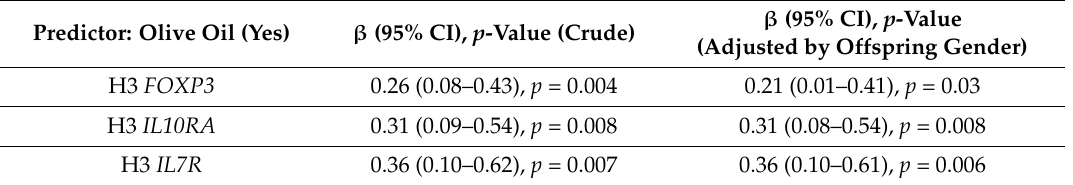
Table 2. Association between olive oil consumption and H3 acetylation levels in placenta in anthroposophic and partly anthroposophic families ( n = 125 *).